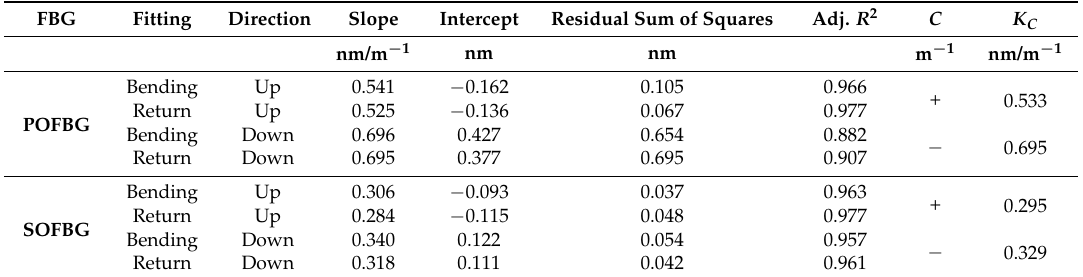
Curvature [m -1 ] Figure 4. Bend response of POFBG ( a ) and SOFBG ( b ) on the upper surface of brass beam without and with sticky tape fixing vs. the curvature, when the beam is bent upwards.